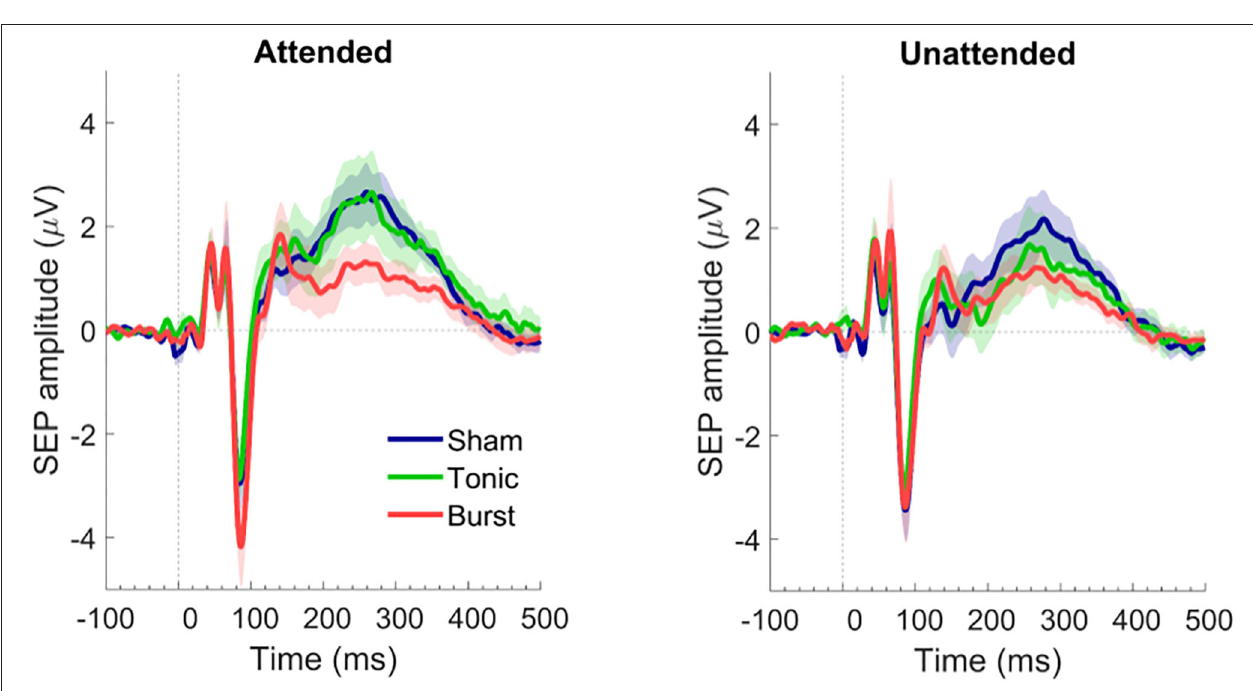
there was a significant reduction in P300 amplitude when patients were under burst SCS regime as compared with sham and tonic SCS regimes ( Figure 3 ). Even though both burst and sham